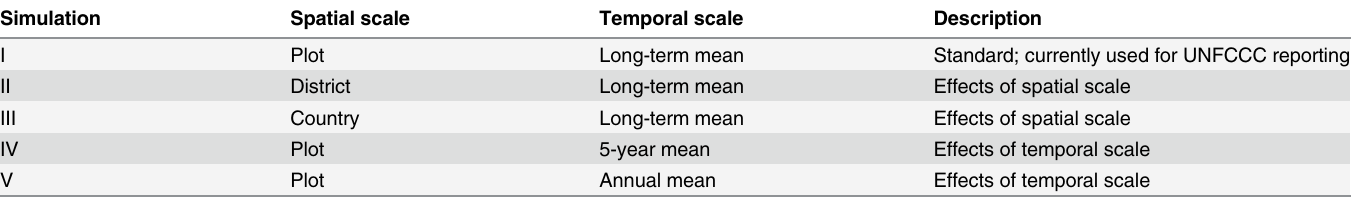
Table 3. List of simulations and the spatial and temporal aggregation levels applied for climatic input. Simulation Spatial scale Temporal scale Description Long-term mean Standard; currently used for UNFCCC reporting Long-term mean Effects of spatial scale Long-term mean Effects of spatial scale 5-year mean Effects of temporal scale Annual mean Effects of temporal